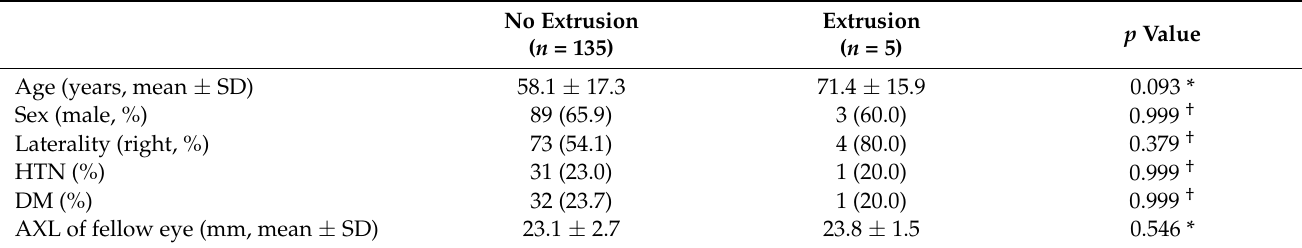
Table 1. Demographic features of